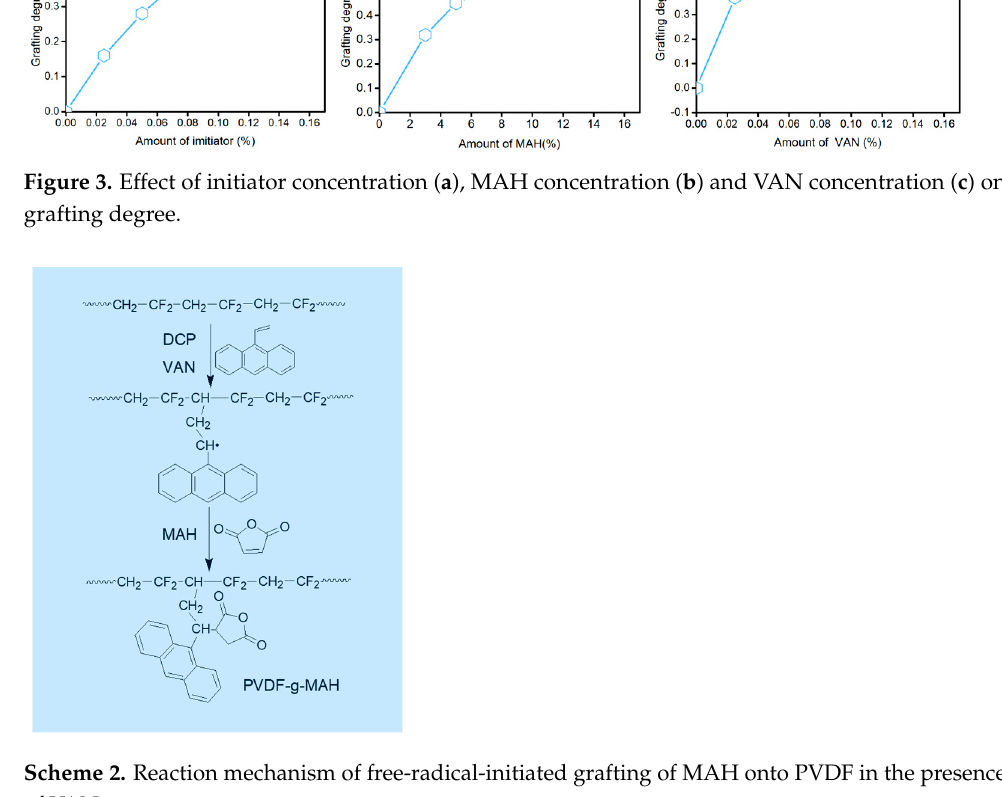
Figure 4. Rheological properties of PVDF, PVDF/MAH and PVDF-g-MAH (G = 0.63%): ( a ), viscosity; ( b ), viscosity modulus; ( c ), elasticity modulus; ( d ), compiex modulus.